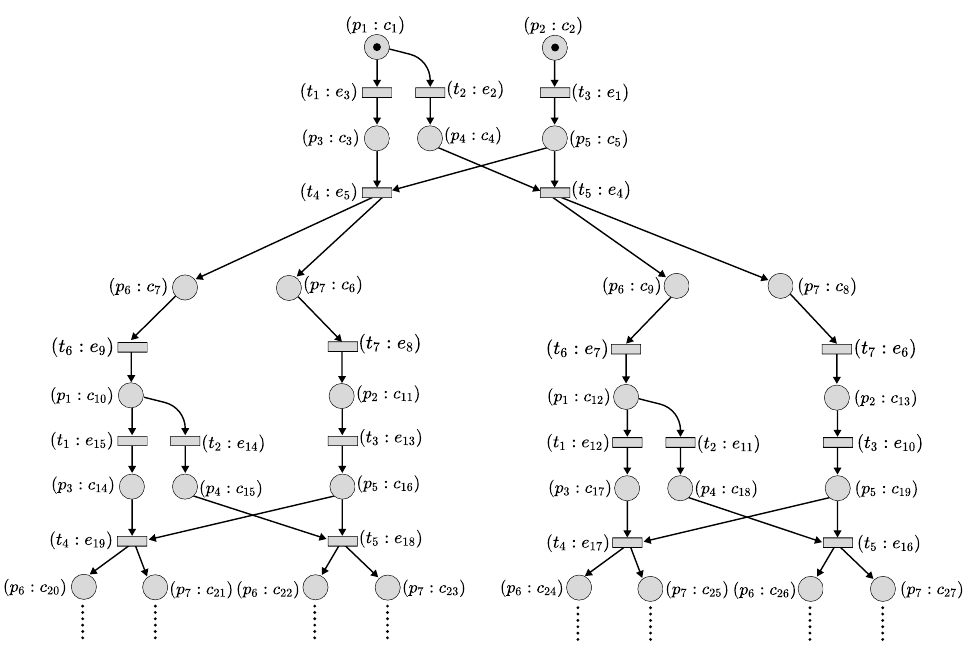
Figure 5. A graphical representation of the maximal branching process (unfolding) of the net system in Figure